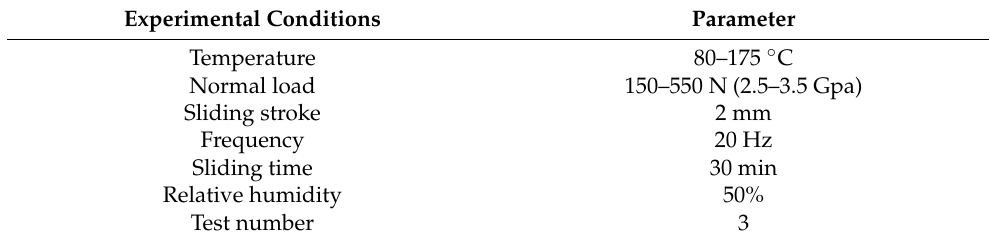
Table 1. Experimental conditions for study on the lubrication performance of grease.